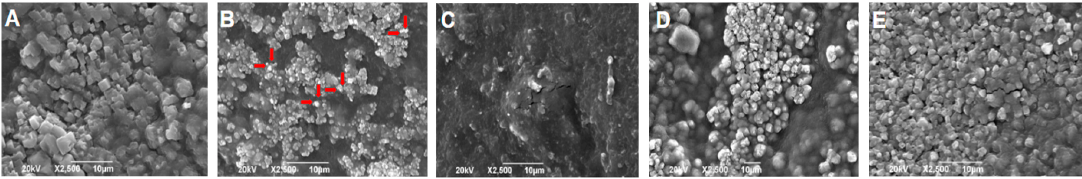
Figure 9. Morphology of CS / PVA / GO films after seven days in the degradation process in SBF. ( A ) F1: CS/PVA/GO 20:80:0; ( B ) F2: CS/PVA/GO 14.75:85:0.25; ( C ) F3: CS/PVA/GO 19.5:80:0.5; ( D ) F4: CS/PVA/GO 14.25:85:0.75; ( E ) F5: CS/PVA/GO 29:70:1. All the ratios are wt %.